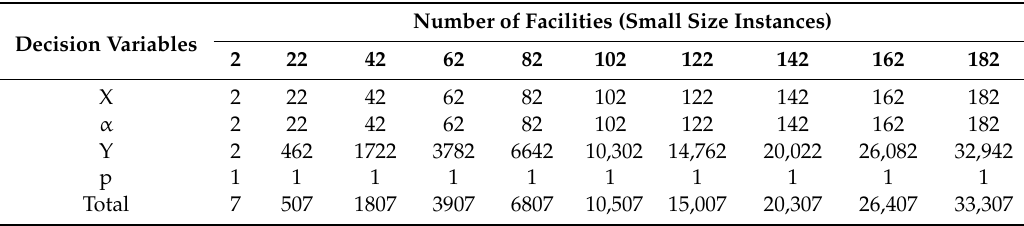
Table 7. CLITraP- HTF dimension of decision variables after applying the DRP on n, T, q and δ. Table 7. CLITraP-HTF dimension of decision variables after applying the DRP on n, T, q and δ .